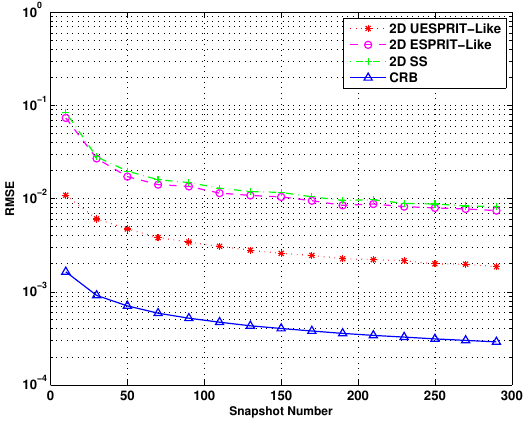
Figure 5. RMSE of the DOA estimates versus snapshot